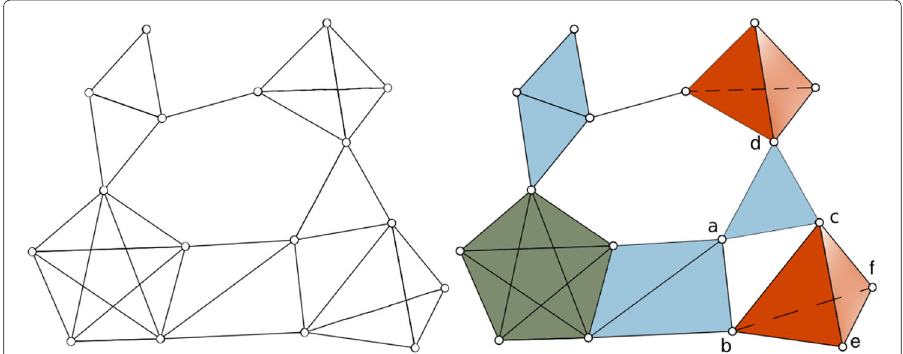
Fig. 3 Network (left) and simplicial complex (right) representation. The (maximal) 2-simplices are in light blue, 3-simplices in red and the 4-simplex is in green. Notice that in the network these are